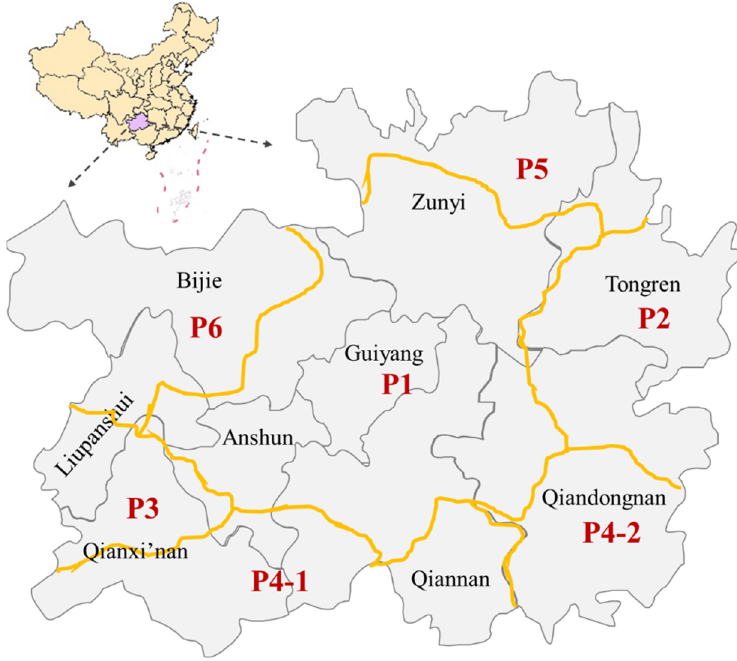
Figure 1. The six ecologically distinct rice farming regions in Guizhou Province.